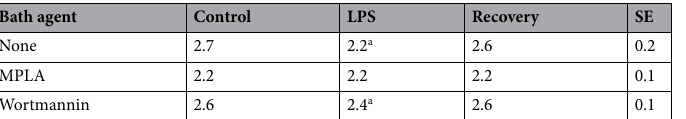
Table 1. Effect of luminal LPS on transepithelial voltage in the presence of specific agents in the bathing solution. Data given as mean with approximate SE in R column. a Significantly different from mean of control and recovery periods, p < 0.01.